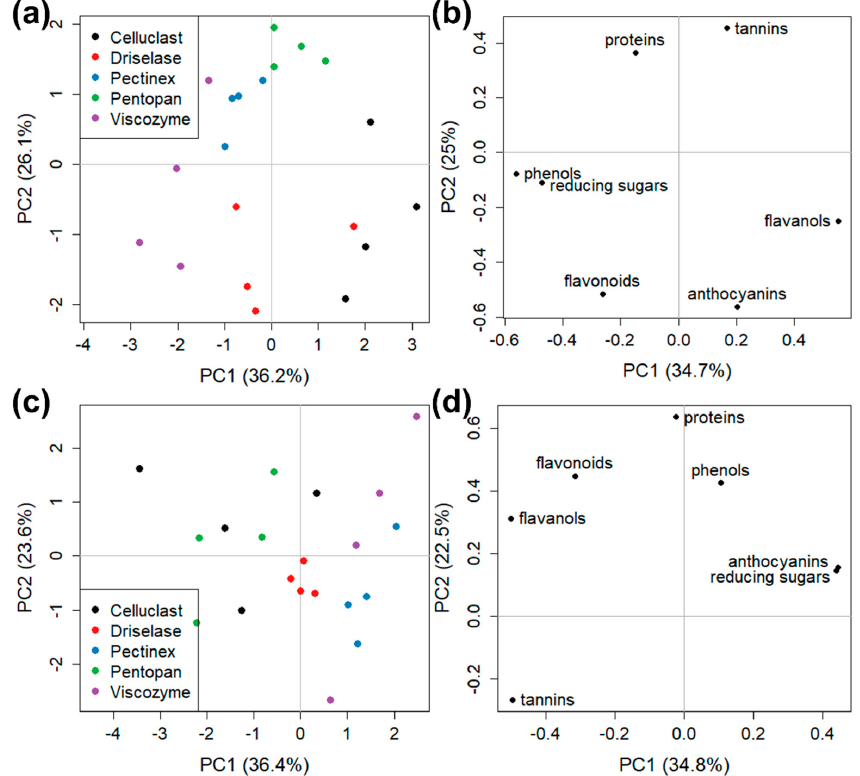
Figure 5. PCA models for ( a , b ) enzymatic and ( c , d ) acetone Merlot GP extracts. Score colors are based on the different enzymes used for the extraction treatment. ( a , c ) score plots and ( b , d ) loading plots.